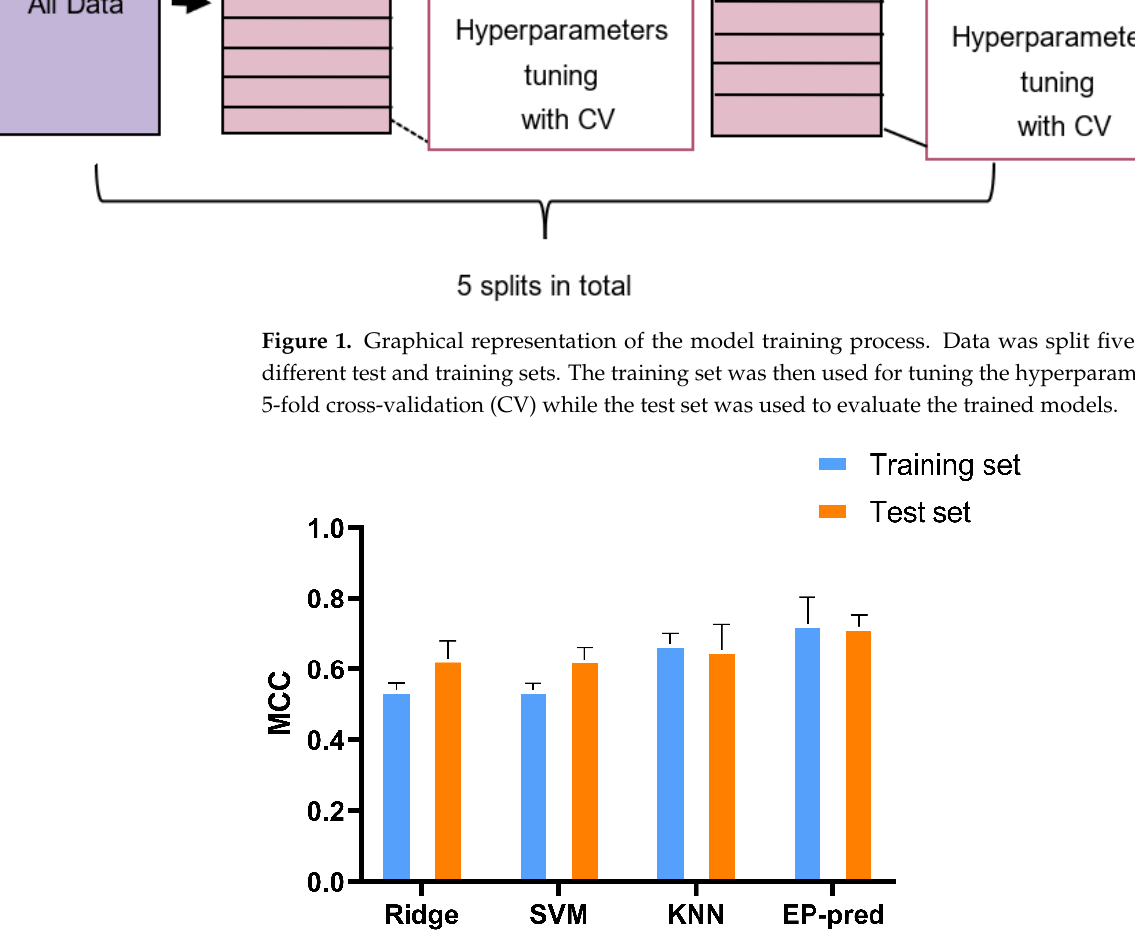
Figure 2. Matthew’s correlation coefficient (MCC) scores of the different classifiers. Ridge is the RidgeClassifier which is one of the linear models implemented in Scikit-Learn; SVM is the support vector machine; KNN is the K-nearest neighbors and EP-pred is the ensemble classifier that combined all 3 of the previous classifiers.